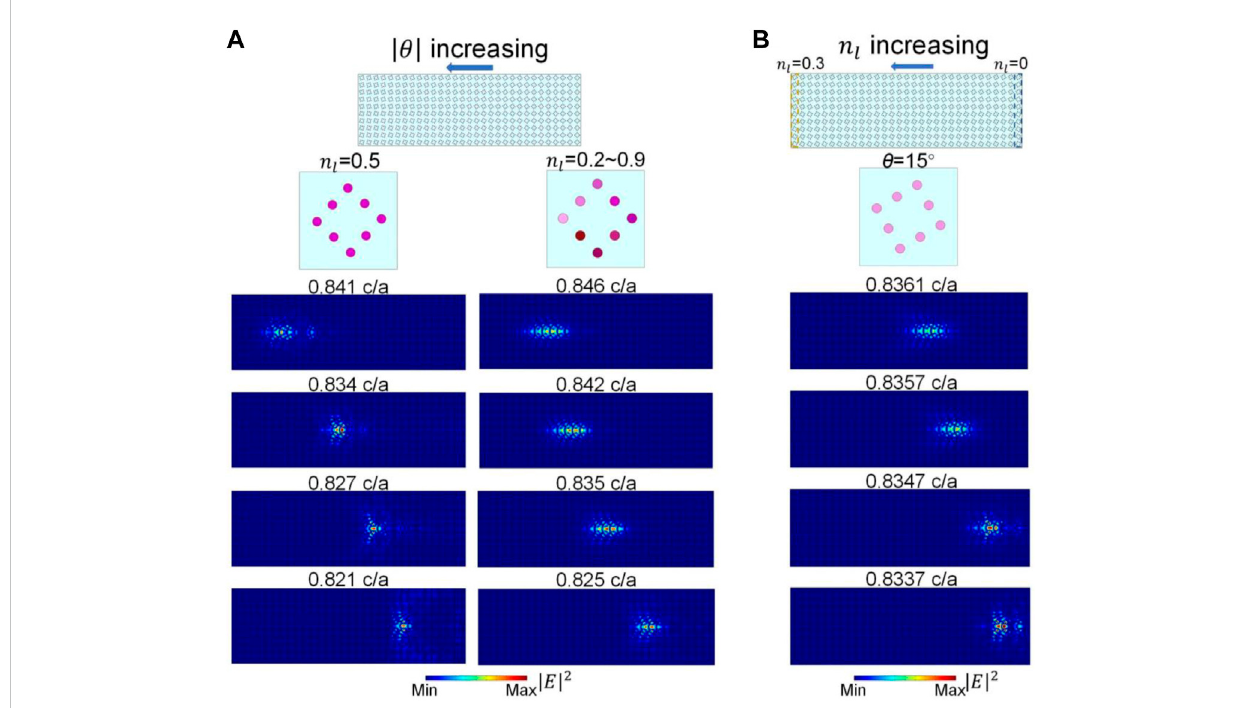
FIGURE 3 (A) Angleofthestructureisgraduallyincreasing( | θ | =0 ° ~30 ° ).Acertainlossisappliedoneachpillarofacell.Twocasesarecalculated.Thesameloss ( n l = 0.5) and different losses ( n l = 0.2~0.9) are applied to each pillar in a cell separately. The | E | 2 distribution pro fi les are shown below the unit cells, correspondingly. (B) Angle of the structure is certain ( | θ | = 15 ° ). The gradient loss ( n l = 0~0.3) applied on the structure is used to achieve topological rainbow trapping. The | E | 2 distribution pro fi les are shown below the unit